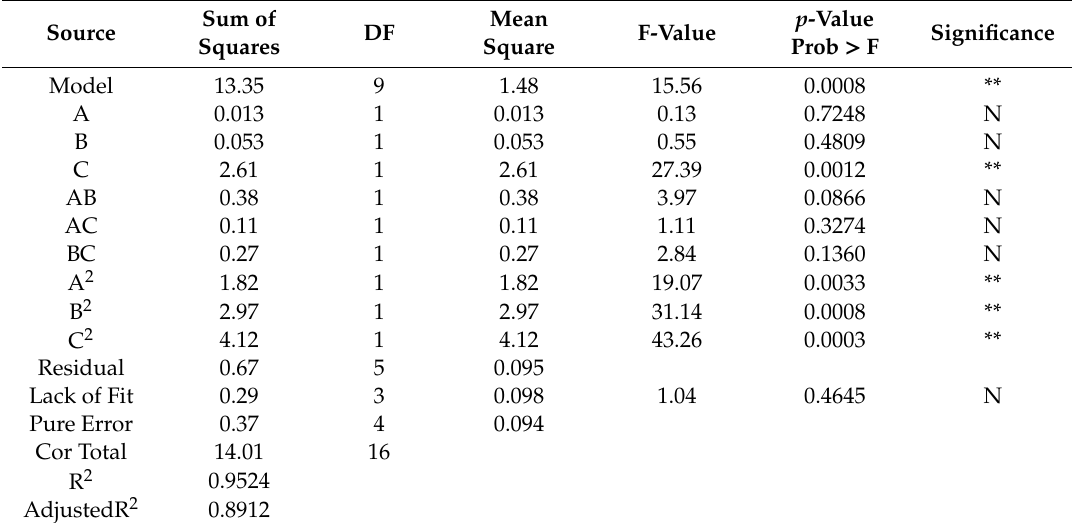
Table 2. ANOVA analysis of experimental